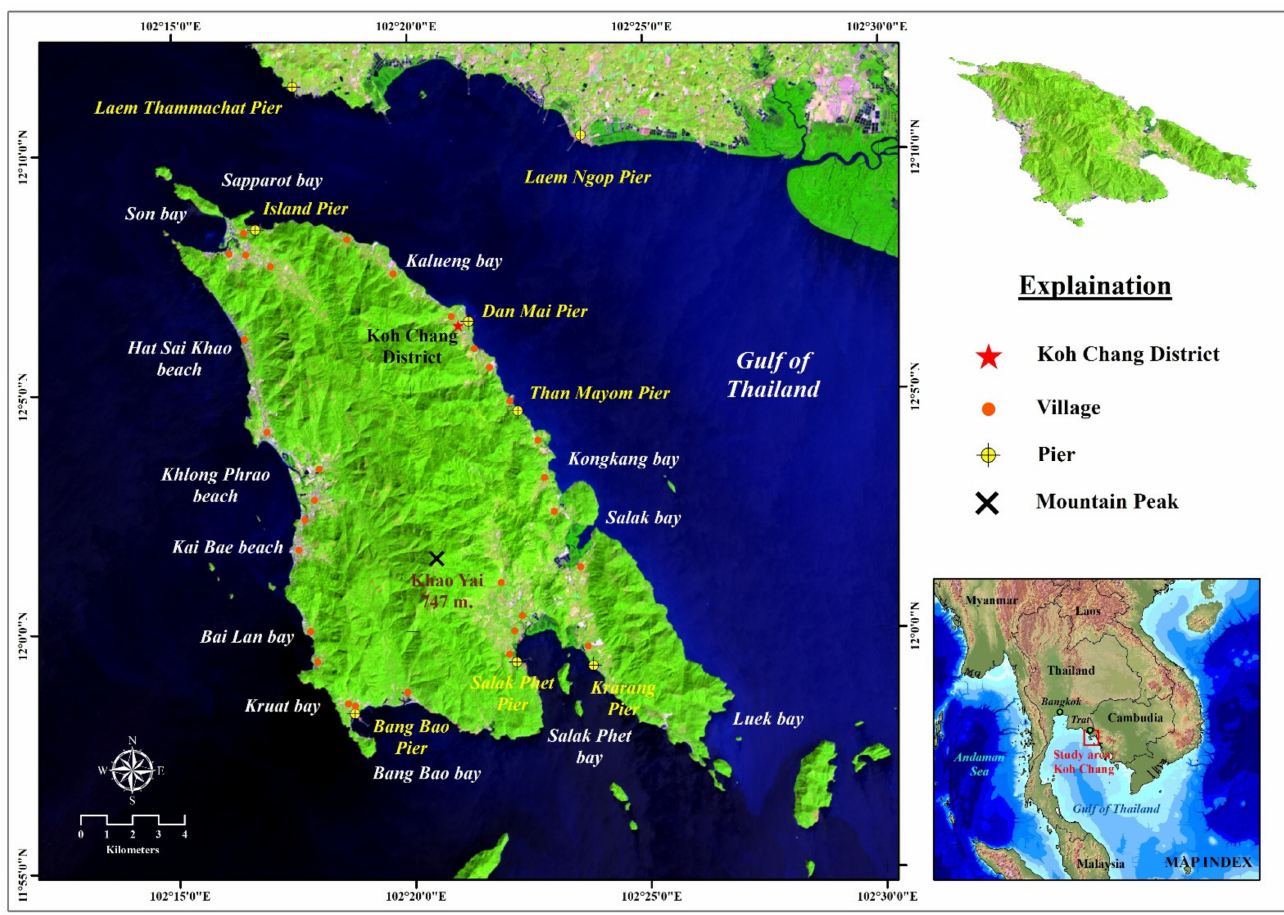
Figure 1. Location maps of the study area.